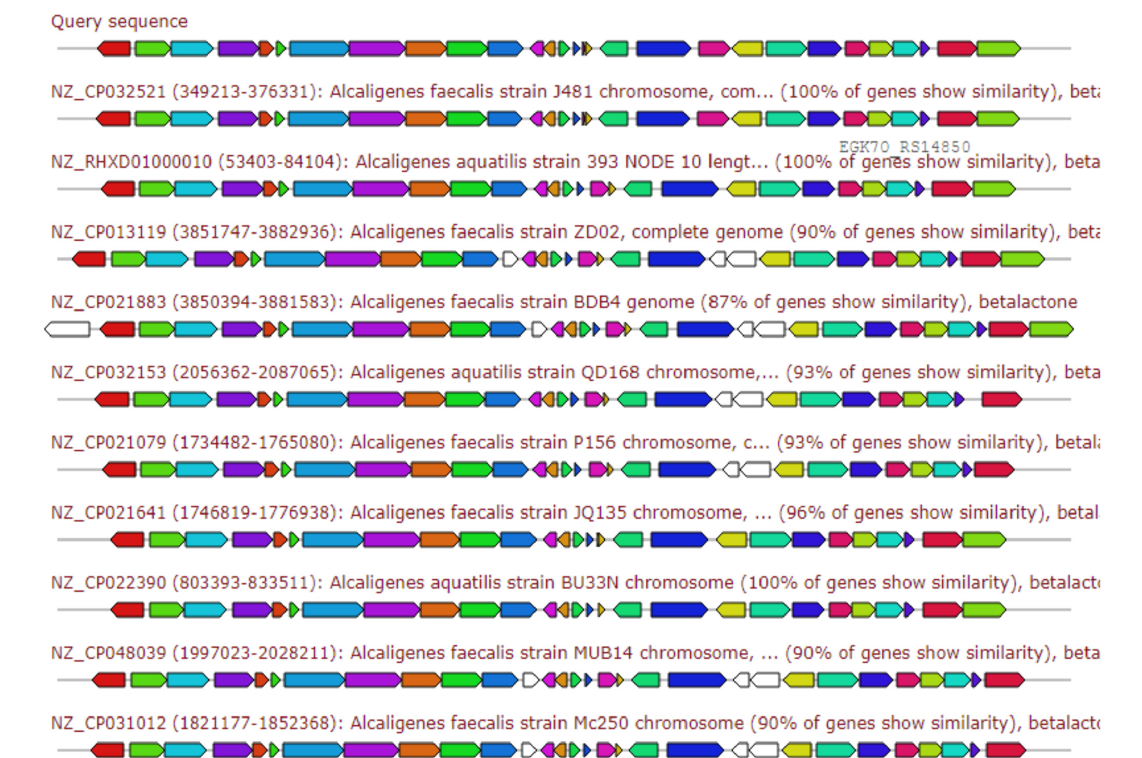
11 of 19 Figure 5. Gene arrangement of resorcinol and multi-modular non-ribosomal peptide synthase (NRPS) gene clusters of various Alcaligenes sp. homologous to query sequence of A. faecalis isolate MZ921504. Putative biosynthetic genes presented